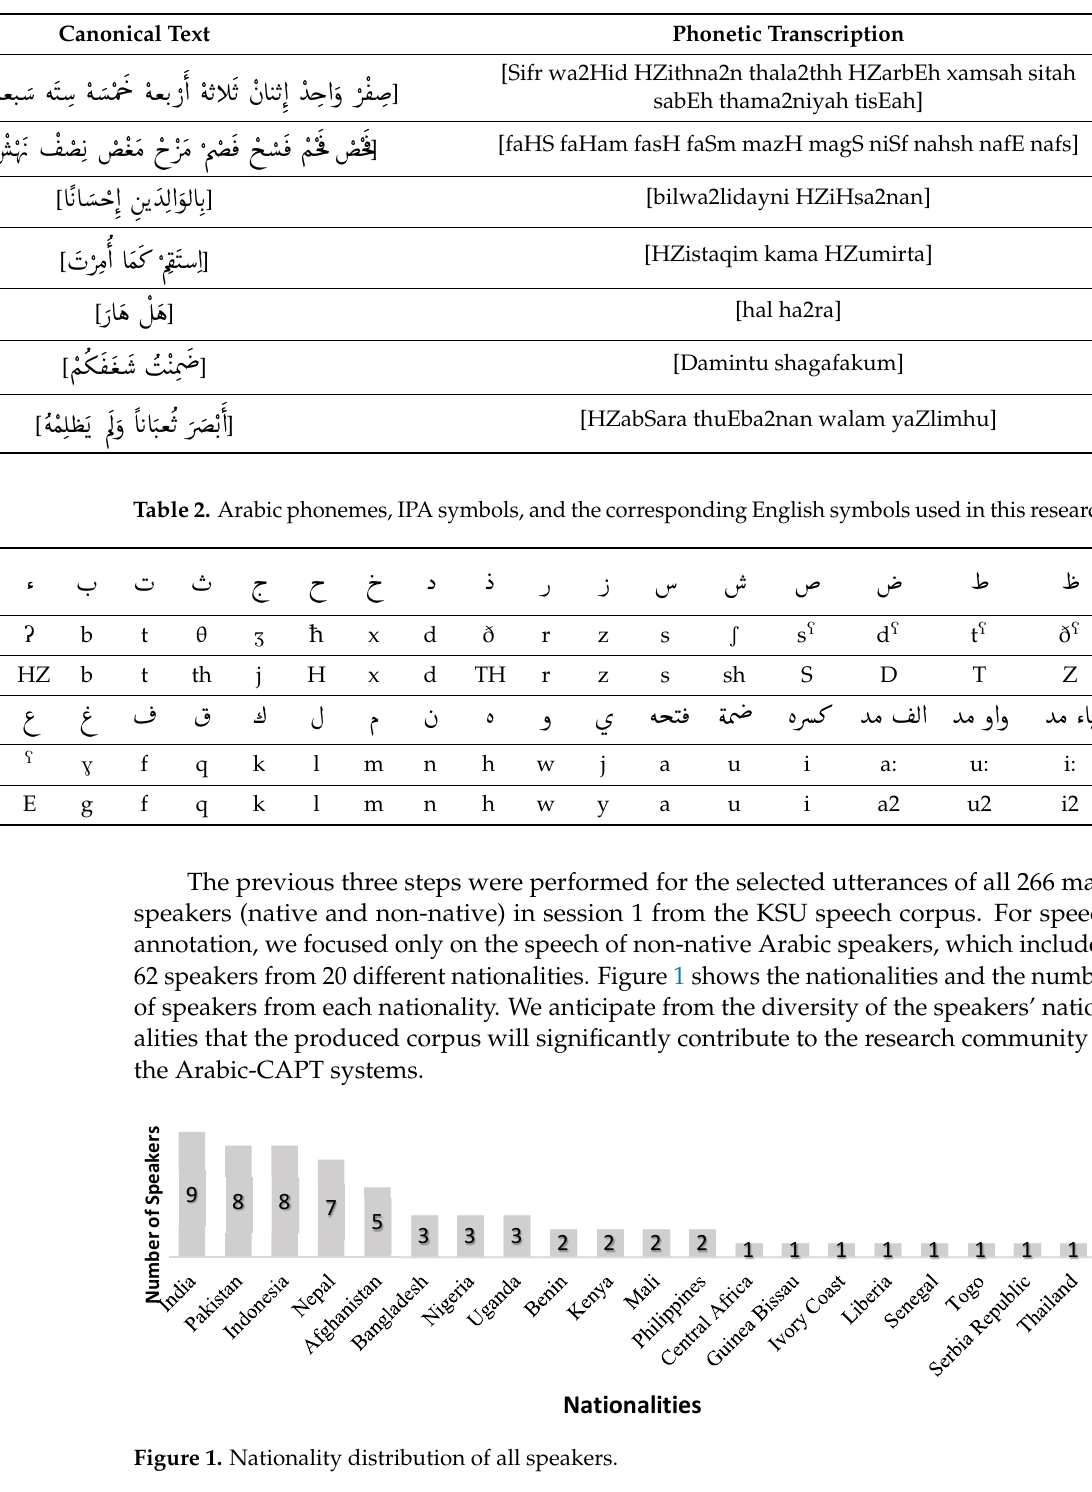
Table 1. Examples of the selected text.